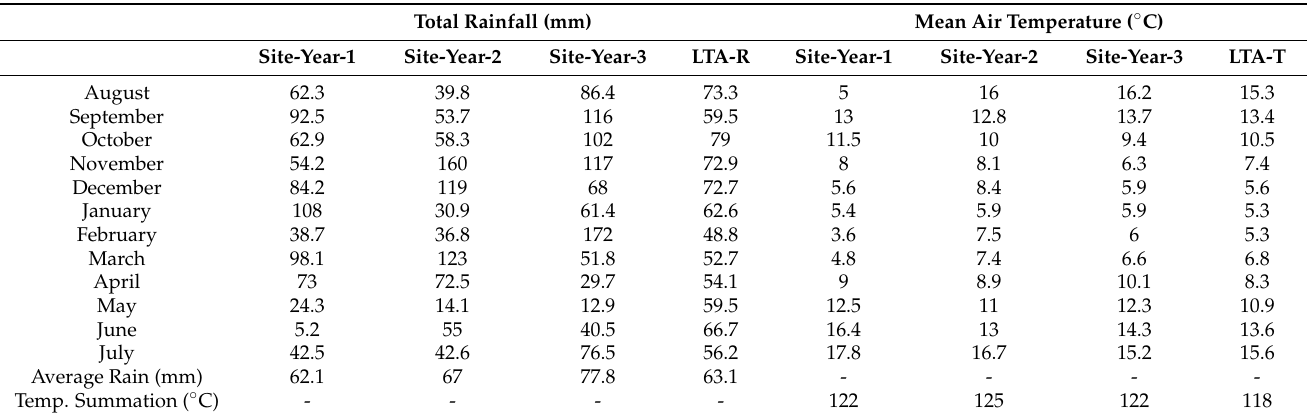
Table 3. Monthlyrainfall(mm)andmeanairtemperature( ◦ C)atOakParkduringthreeyearsofexperiment with LTA (1981–2010) with a final rainfall average and a summation of temperature across